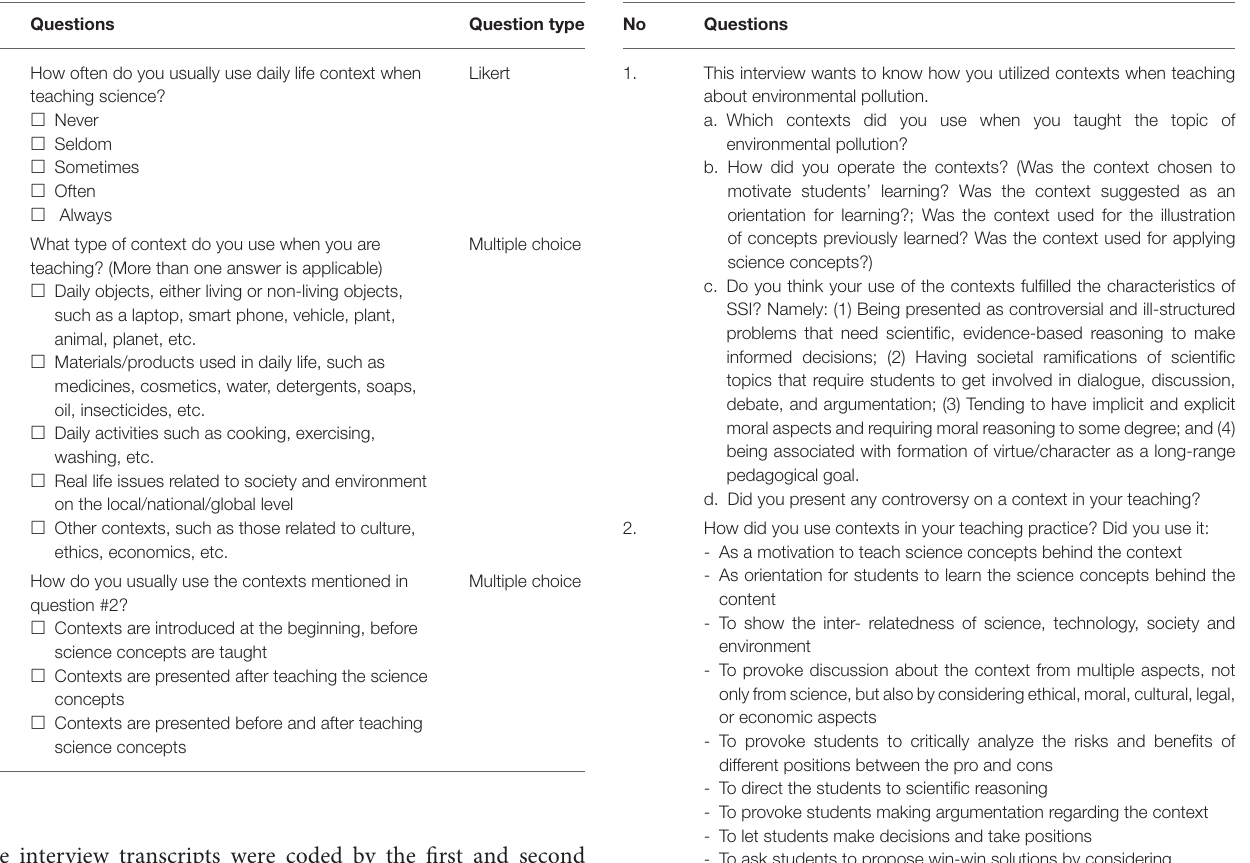
TABLE 2 | Description of the questions in the questionnaire. TABLE 3 | Questions in the interview; leading question and potential